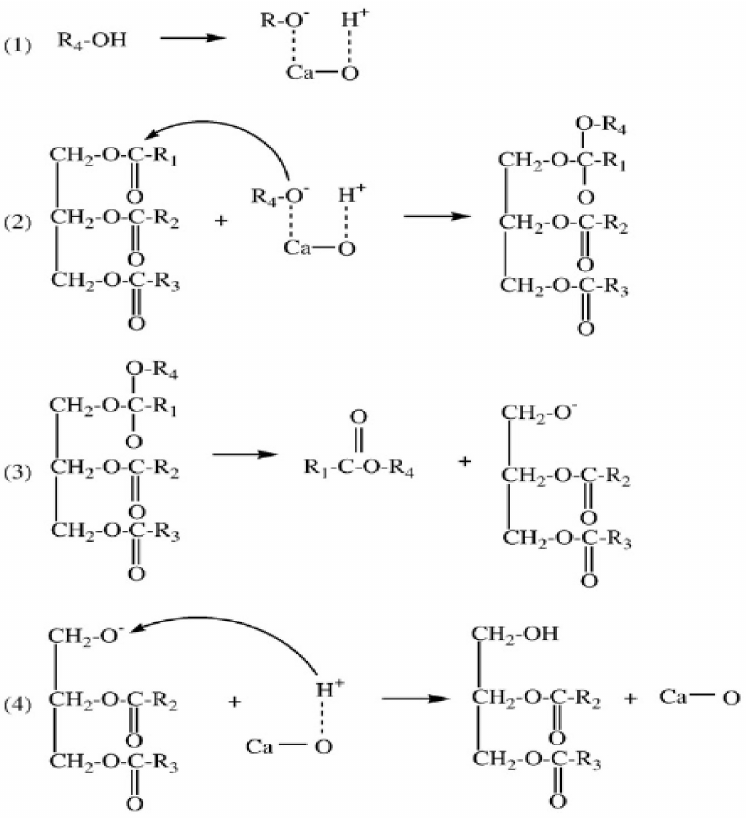
Figure 2. Mechanism of CaO-catalyzed transesterification [38]. R 1, R 2, R 3 are carbon chain of fatty acid and R 4 is alkyl group of the